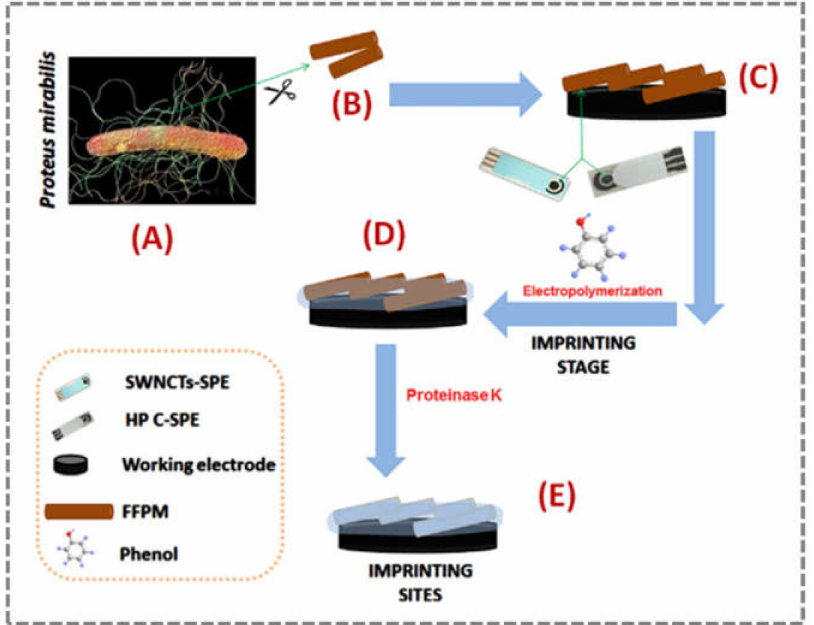
Figure 7. Scheme of MIP synthesis in the development of an impedance biosensor for rapid detection of foodborne pathogenic bacteria: P. mirabilis with flagellar filaments (FFPM) ( A ), which were removed from cells by shearing in a vortex with a glass bar and then passing repetitively through a syringe ( B ), and then FFPM were immobilised at the working area of SWCNTs-SPE/HP C-PE ( C ), followed by imprinting through electropolymerisation of phenol in acetate buffer ( D ), and binding sites formed after template removal by proteinase K ( E ) (reproduced with permission from Khan et al. (2017) [94], Copyright 2017, Elsevier B.V.).